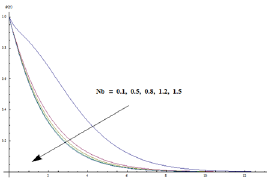
Figure 15. Variation in Nusselt and Sherwood numbers for different values of Nb vs Nt when l 1 ~ 0 : 3, b ~ 0 : 2, M ~ 0 : 5, Figure 13. Variation in dimensionless concentration w ( g ) vs g